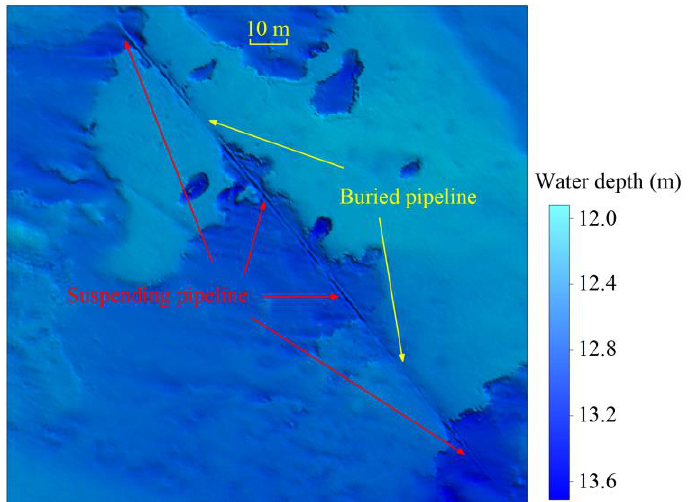
Figure 13. Seabed topography around a submarine pipeline in the subaqueous Yellow River Delta, as detected by a multi-beam sounding system.